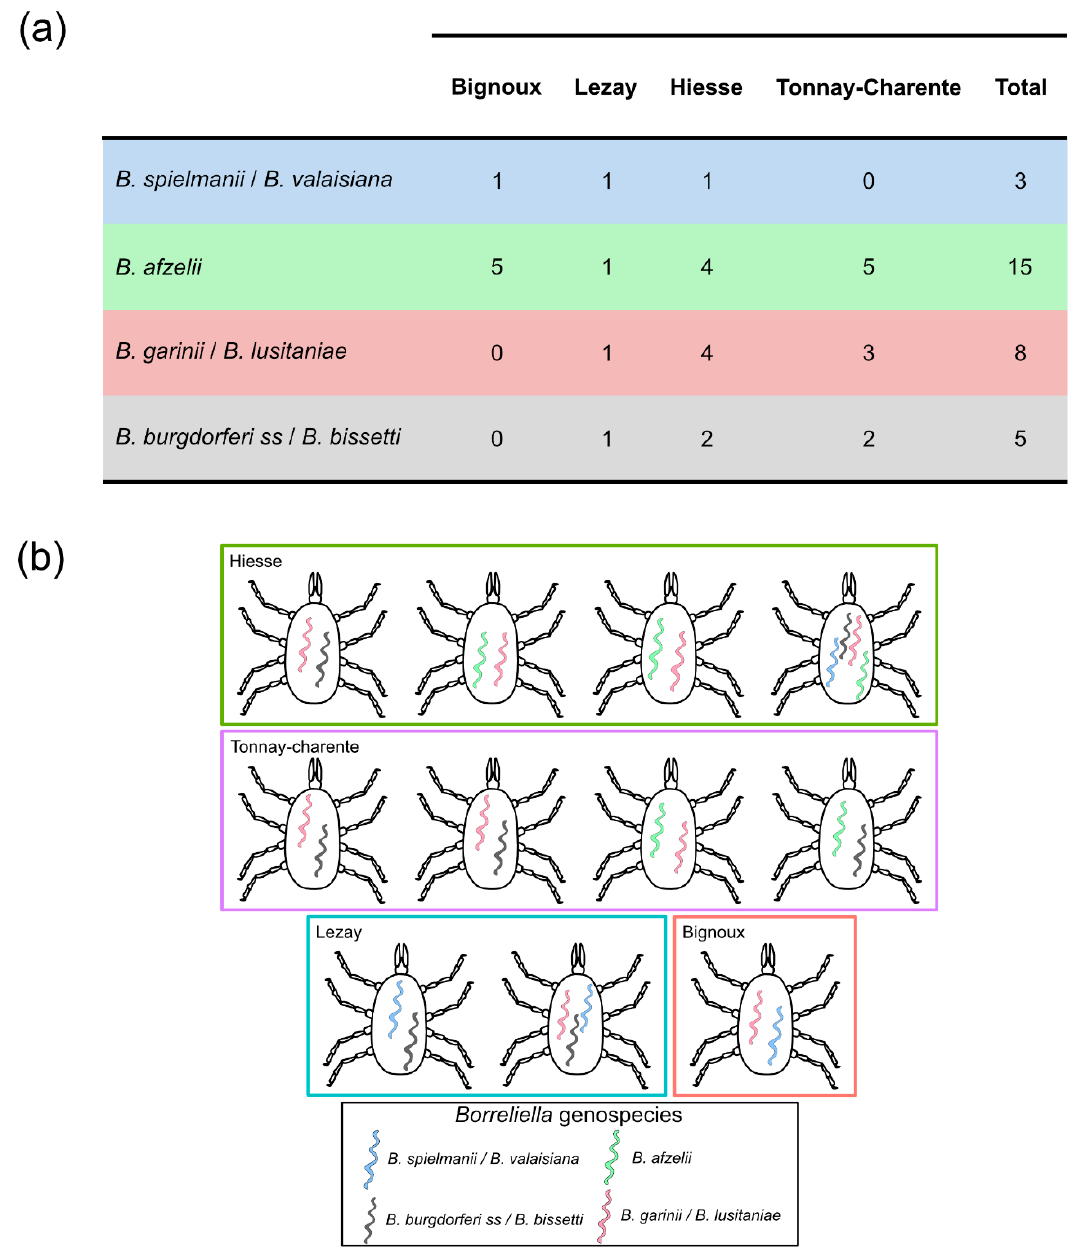
Figure 6. The presence of Borreliella in I. ricinus nymphs at the individual level. ( a ) The number of samples infected by Borreliella genospecies for each sampling site. A sample was considered positive if at least 10 reads for a genospecies were detected. Positive samples presented here can be co-infected by two or more genospecies; ( b ). Schematic representation of the different Borrelellia clusters found within the same infected nymph.